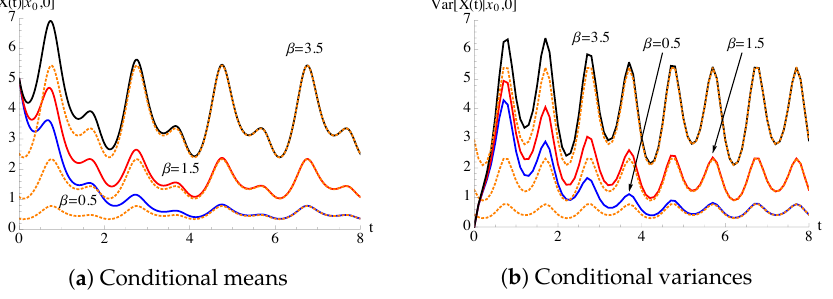
(cid:0) (cid:1)(cid:2) 2 π t 1 +